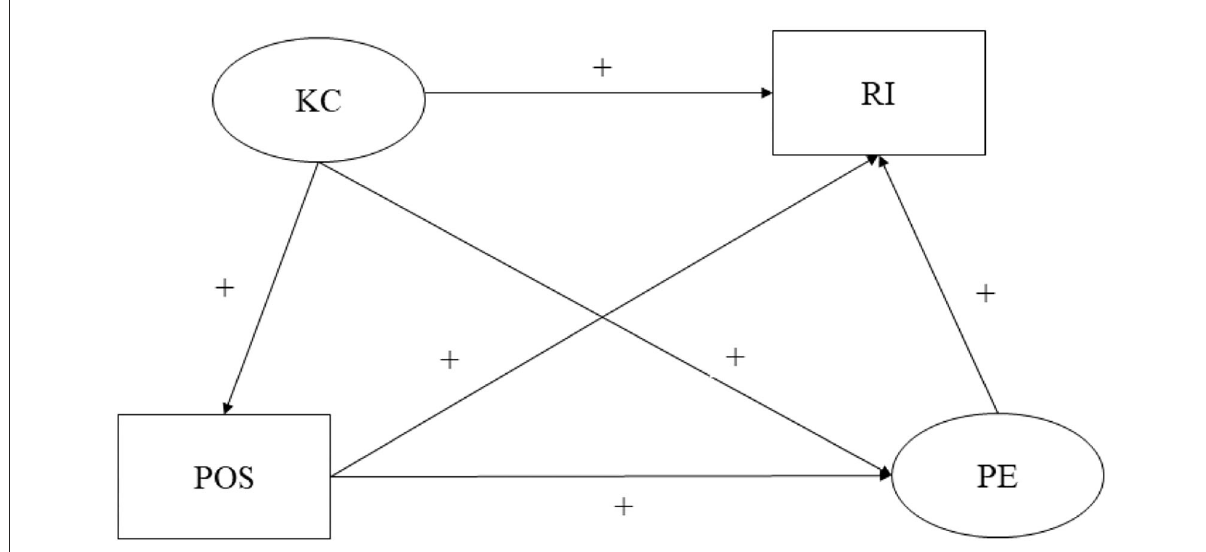
FIGURE1 Conceptual framework of organizational support and psychological empowerment as mediators. KC, kindergarten climate; RI, retention intention; POS, perceived organizational support; PE, psychological